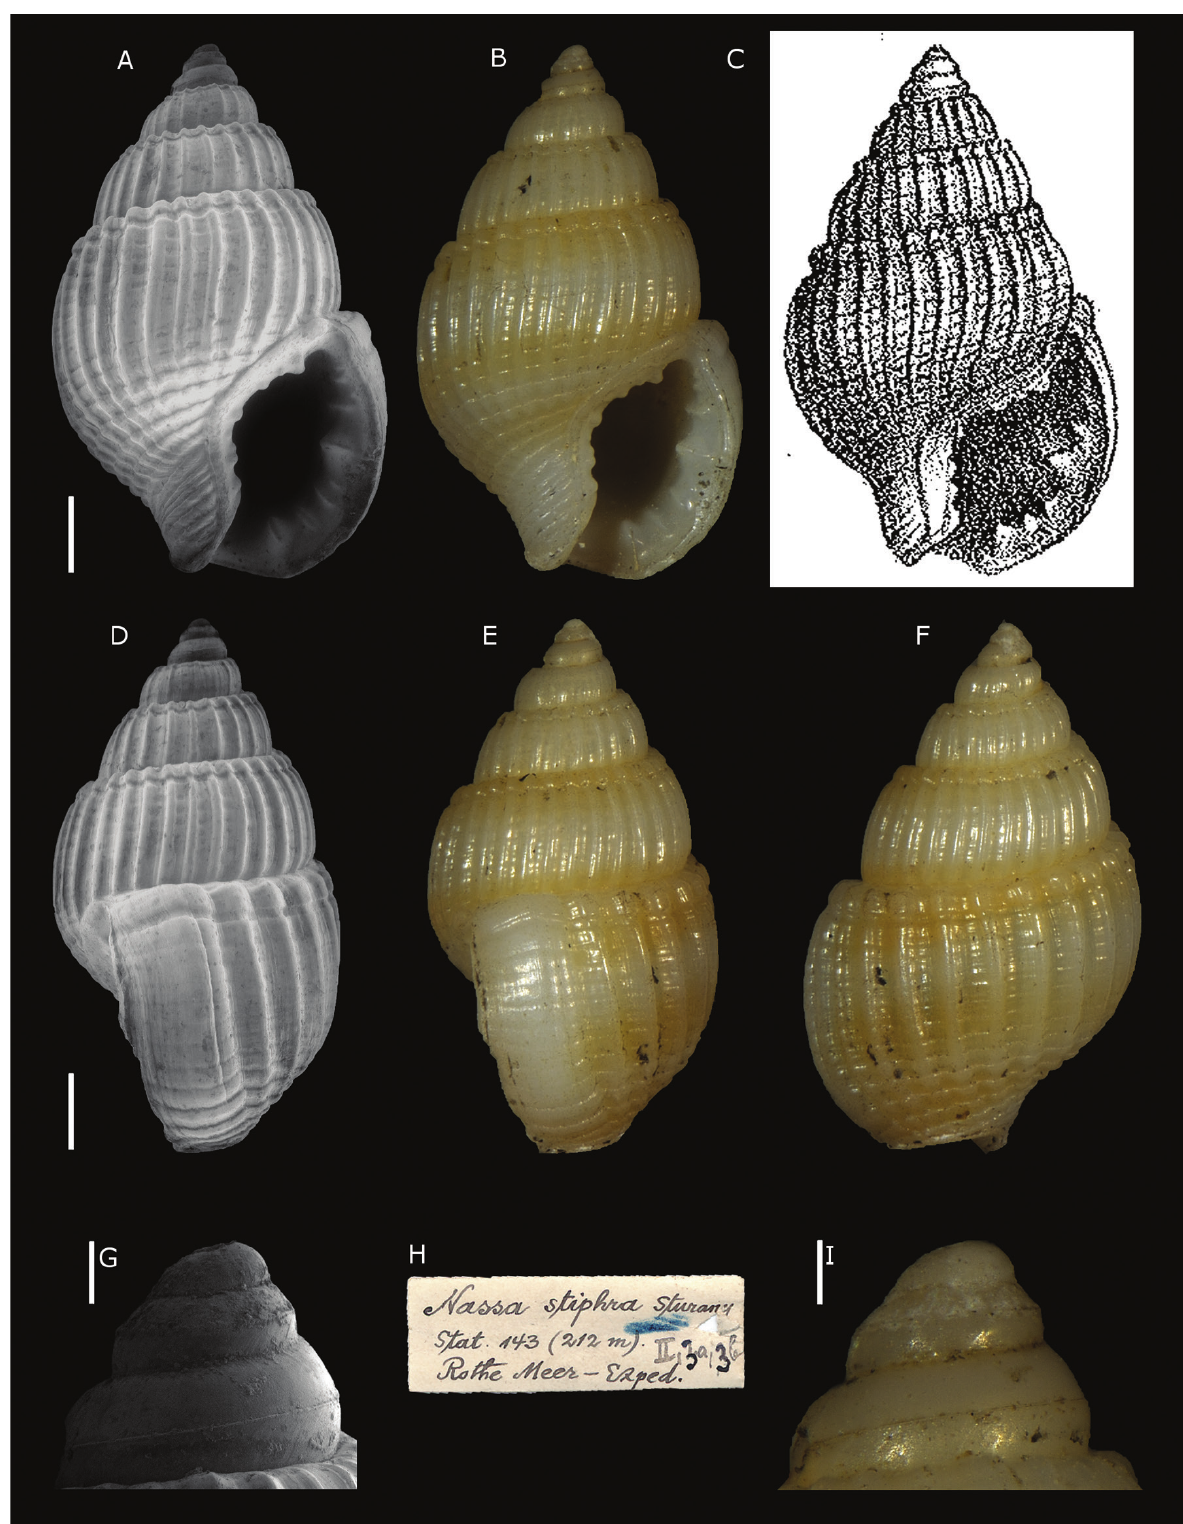
Figure 16. Nassa stiphra Sturany, 1900, Station 143 (Harmil Island, Dahlak Archipelago, Eritrea). A–B , D–G , I . Holotype, NHMW 84195: front ( A–B ), right side ( D–E ), back ( F ), protoconch ( G, I ). C . Original figure by Sturany (1903). H . Original holotype label. Scale bars: A–B , D–F : 1 mm, G , I : 0.2